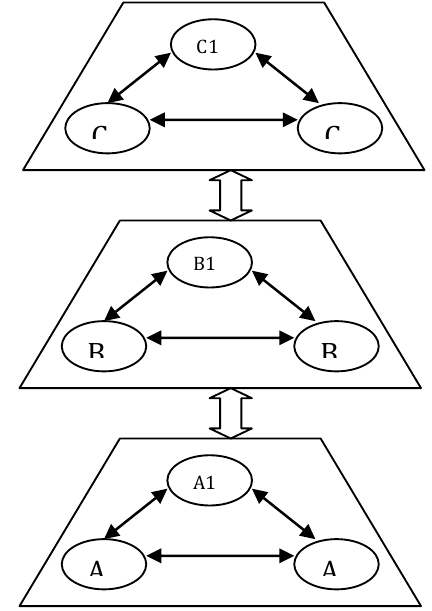
Figure IV. The students’ role layer